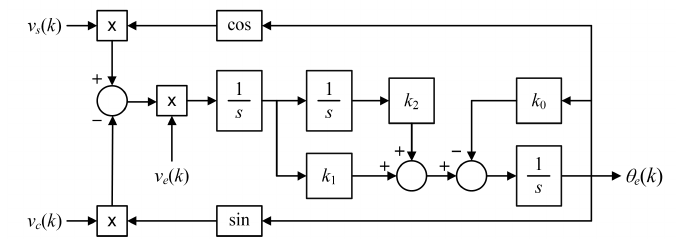
Figure 7. RDC system described in [56].